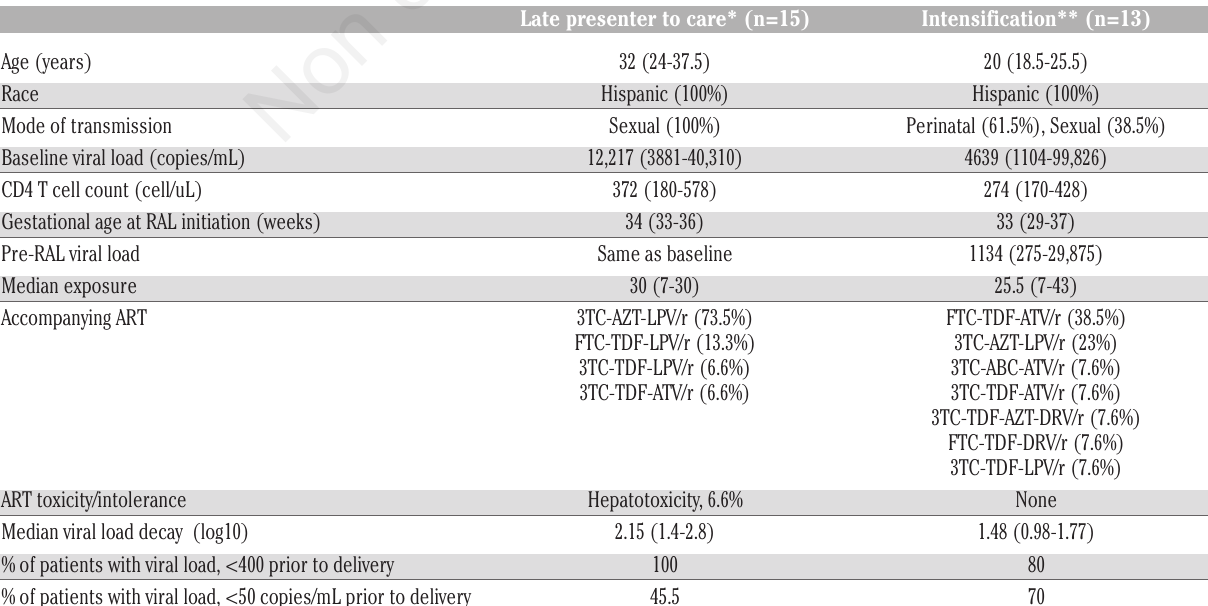
Table 1. Clinical characteristics and virological outcomes in HIV-infected pregnant women that received raltegravir (RAL) as part of antiretroviral therapy (ART) for prevention of perinatal transmission in two clinical scenarios. Values are numbers (median, interquar- tile range) unless otherwise